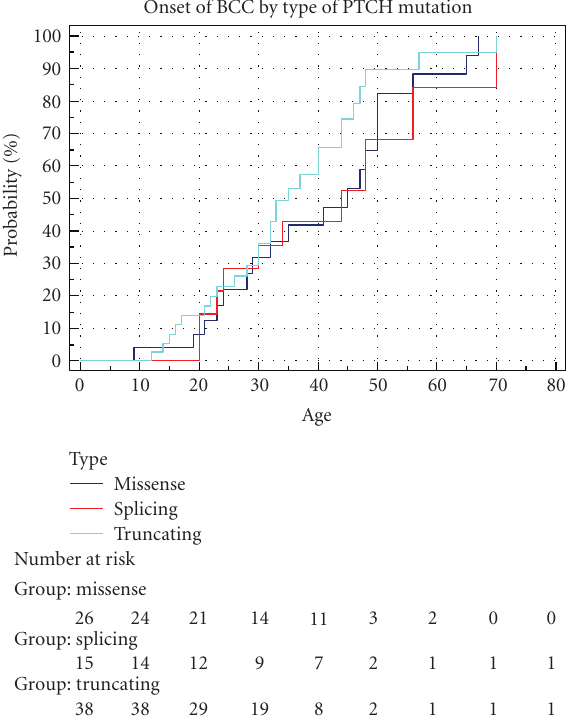
Figure 3: Cumulative onset of BCCs by type of PTCH mutation.